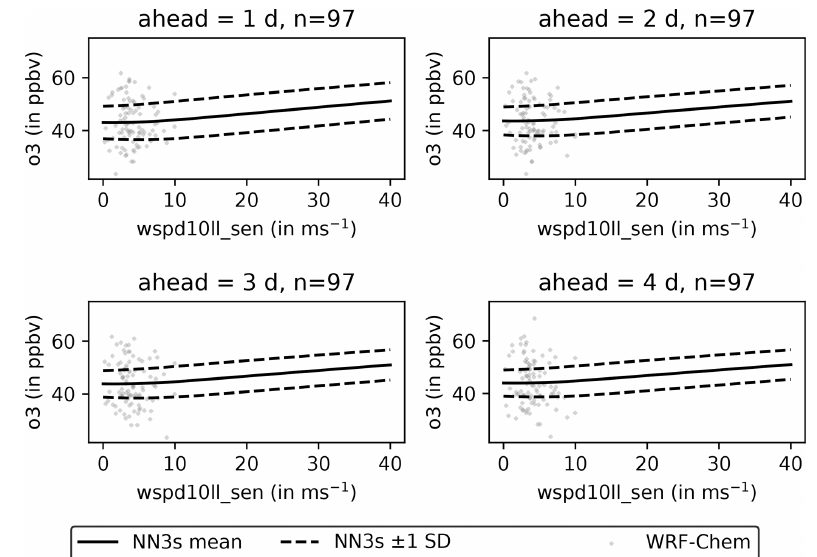
Figure 12. Same as Fig. 11 but for 10m wind speed instead of ozone input.